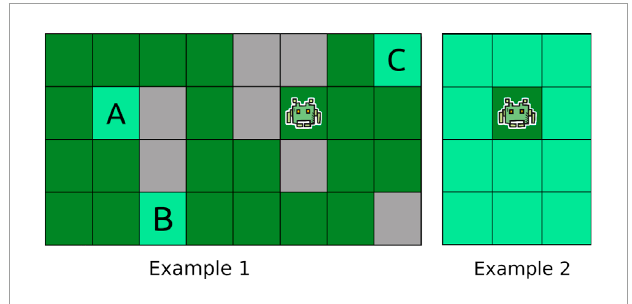
FIGURE 4 Examples explaining how the proposed heuristic works in practice.